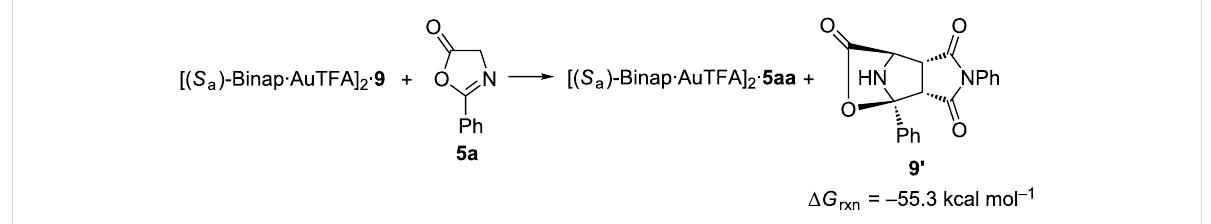
Scheme 5: Δ G calculation for the recovery of the catalytic active species.